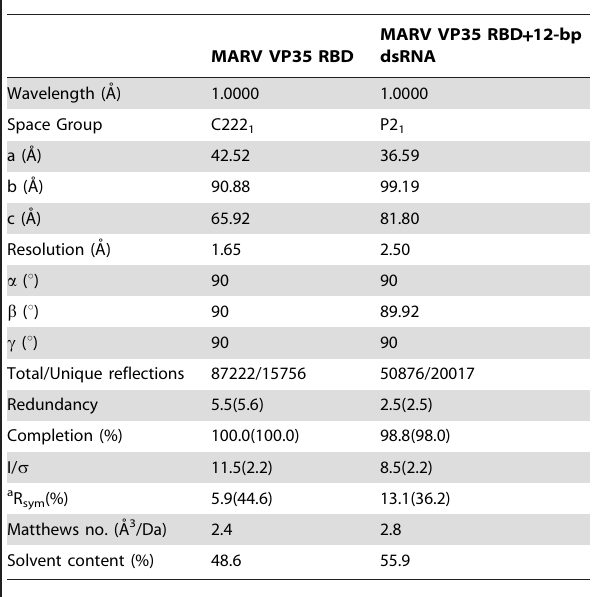
Table 1. Data collection statistics.